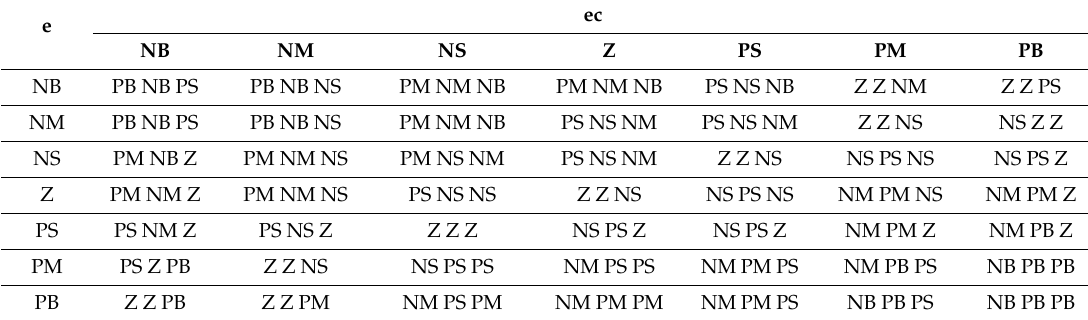
Table 2. ∆ K p , ∆ K i and ∆ K d fuzzy control rules.